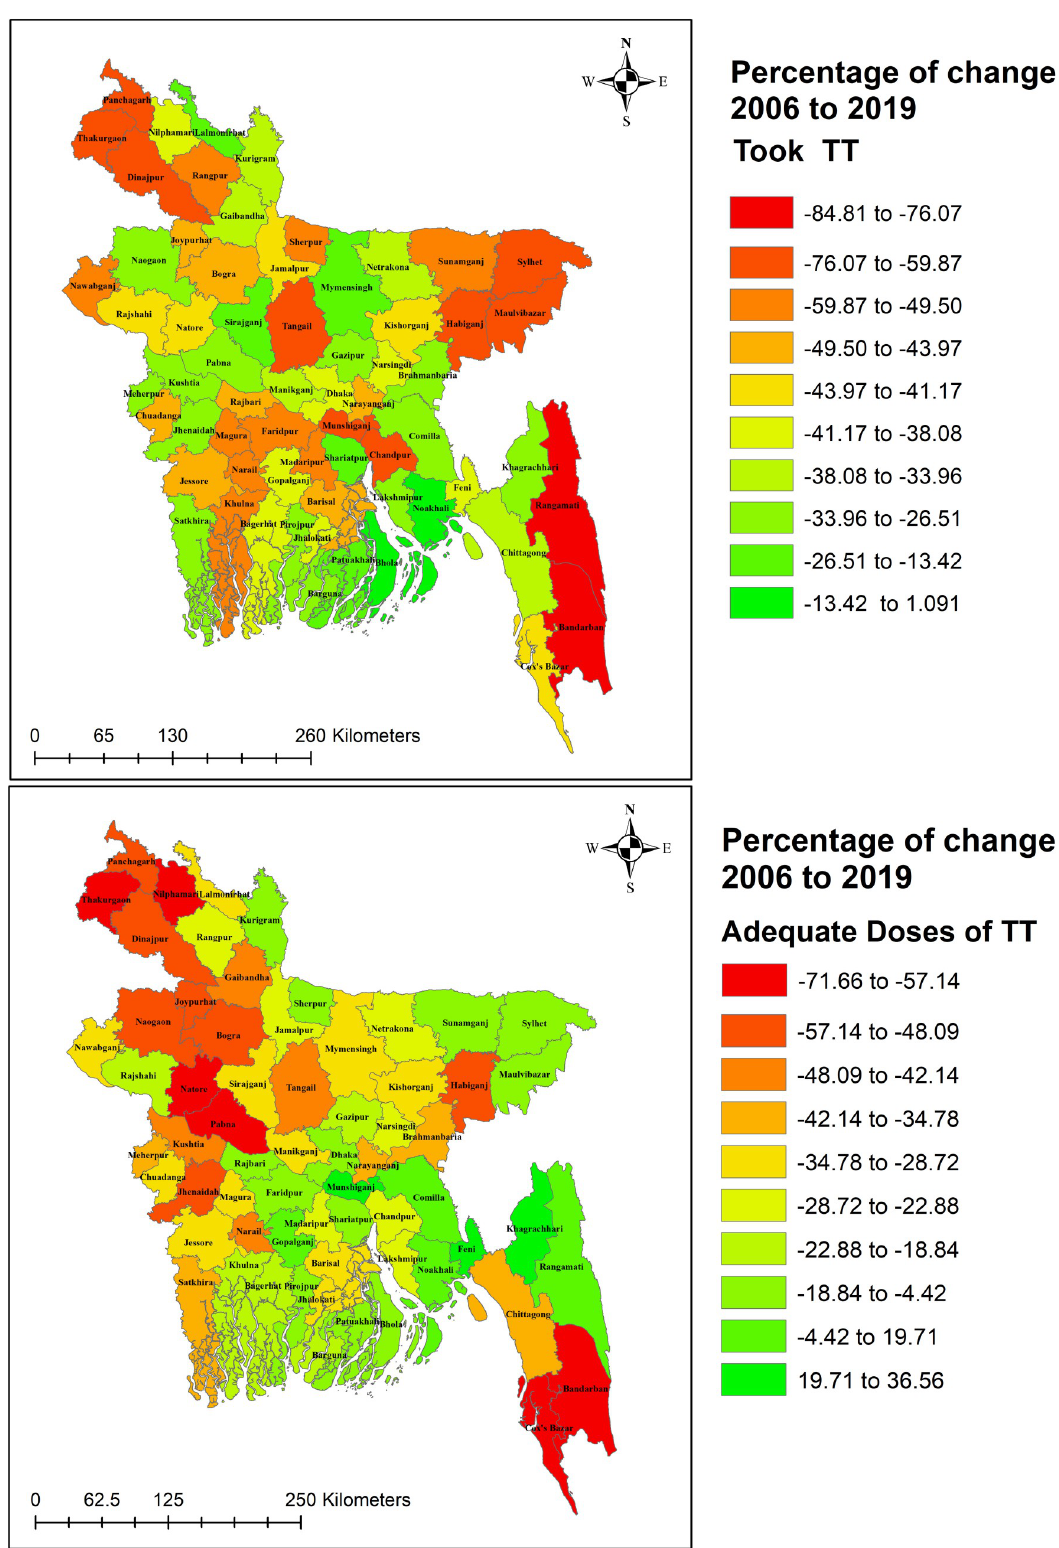
Fig 3. Spatial distribution of change rate of tetanus toxoid vaccination status from 2006 to 2019. Republished from [35] under a CC BY license, with permission from [Bangladesh Agricultural Research Council], original copyright [2014]. https://doi.org/10.1371/journal.pone.0276417.g003 PLOS ONE | https://doi.org/10.1371/journal.pone.0276417 October 20,